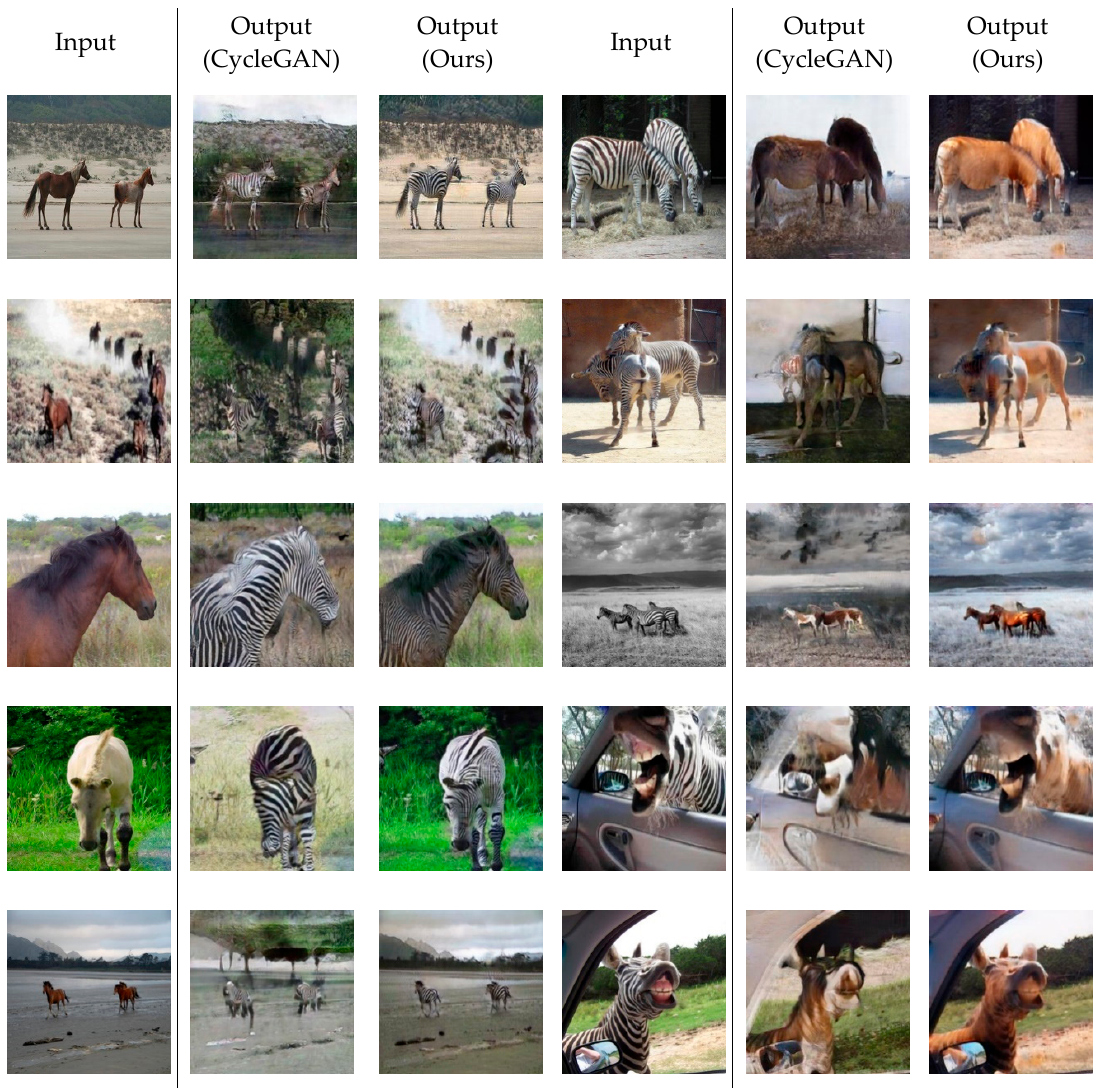
Figure 7. Comparison of pictures translated by CycleGAN and our method from the horse2zebra dataset. CycleGAN results show mistranslations such as changing texture of background, or removing detailed characteristics of the source object, or just inverting image colors. The results of our method show such mistranslations can instead be correctly translated.